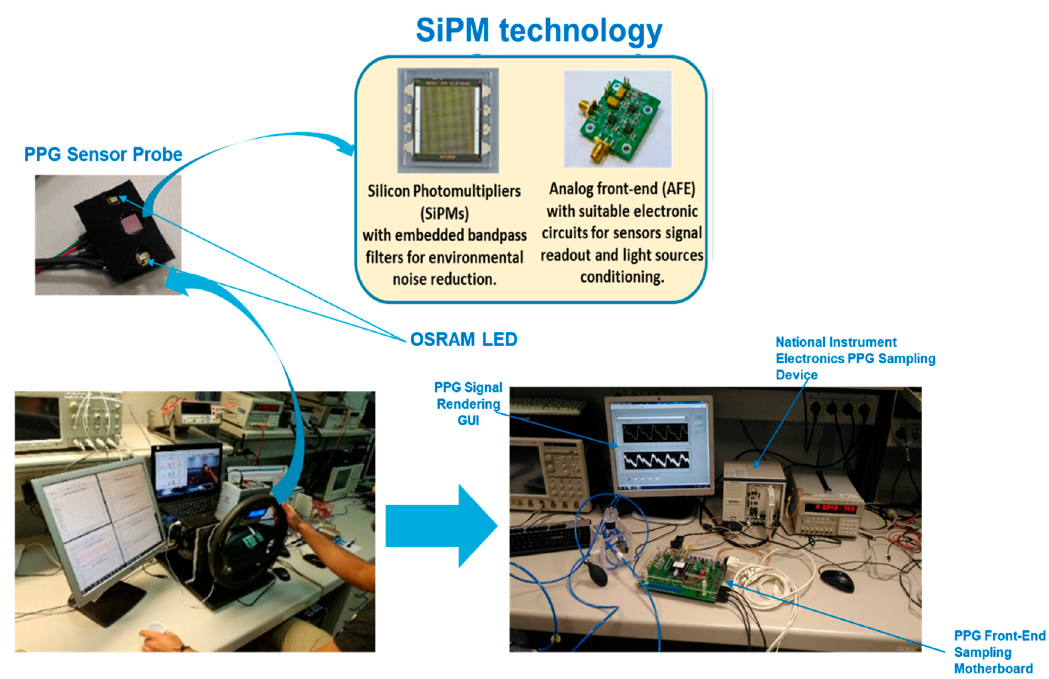
Figure 3. The PPG sampling system for the proposed drowsiness monitoring pipeline.